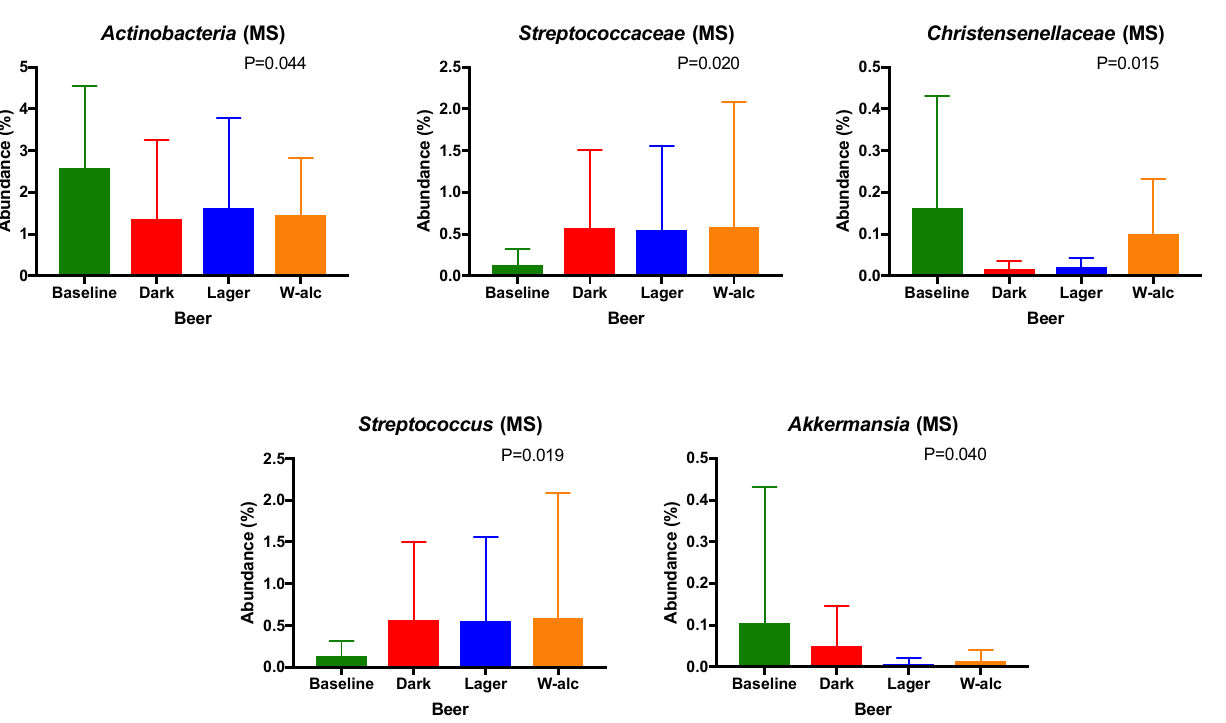
Figure 5. Taxa that changed between the different intervention periods at different taxonomic levels: phylum, family and genus (DesSeq2 test; p < 0.05) within the volunteers with metabolic syndrome. Values are presented as mean ± SD (standard deviation).